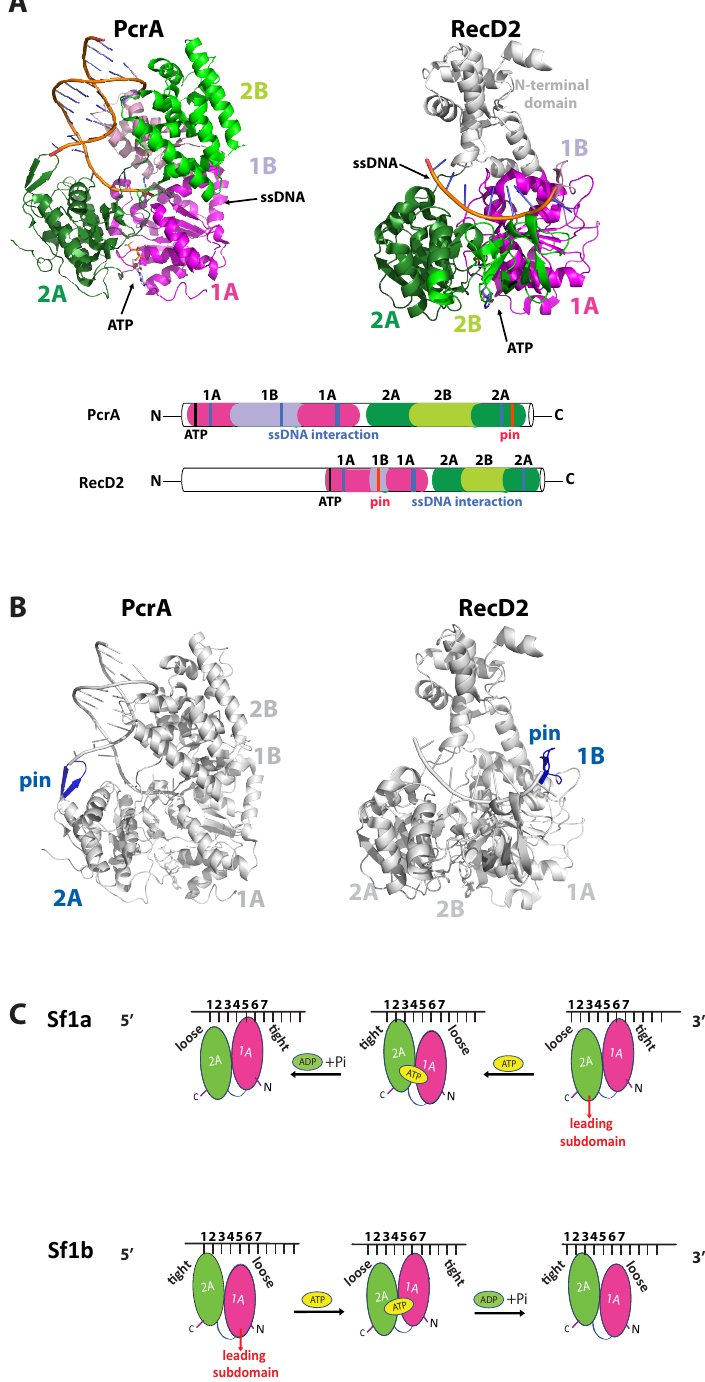
Figure 3. Structure and translocation mechanism of Sf1a and Sf1b helicases. ( A ) Crystal structures (left panel) and diagram (right panel) of PcrA (PDB:3PJR) and RecD2 (PDB:3GPL),